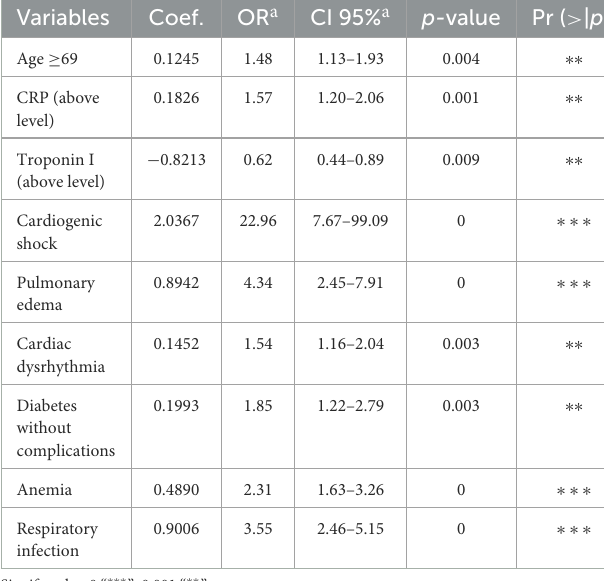
TABLE 5 Predictive factors of LOSE ≥ 11 days for patients with AMI discharged